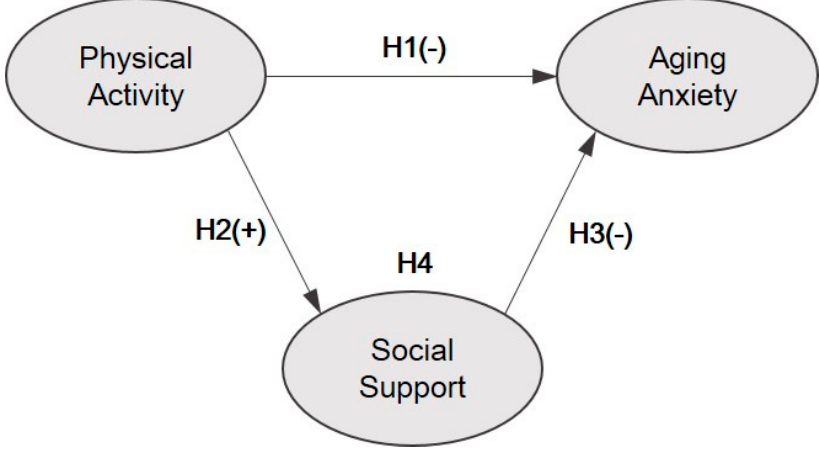
Figure 1. A conceptual model of the relationship between physical activity, social support, and aging anxiety among pre-older adults in Korea.